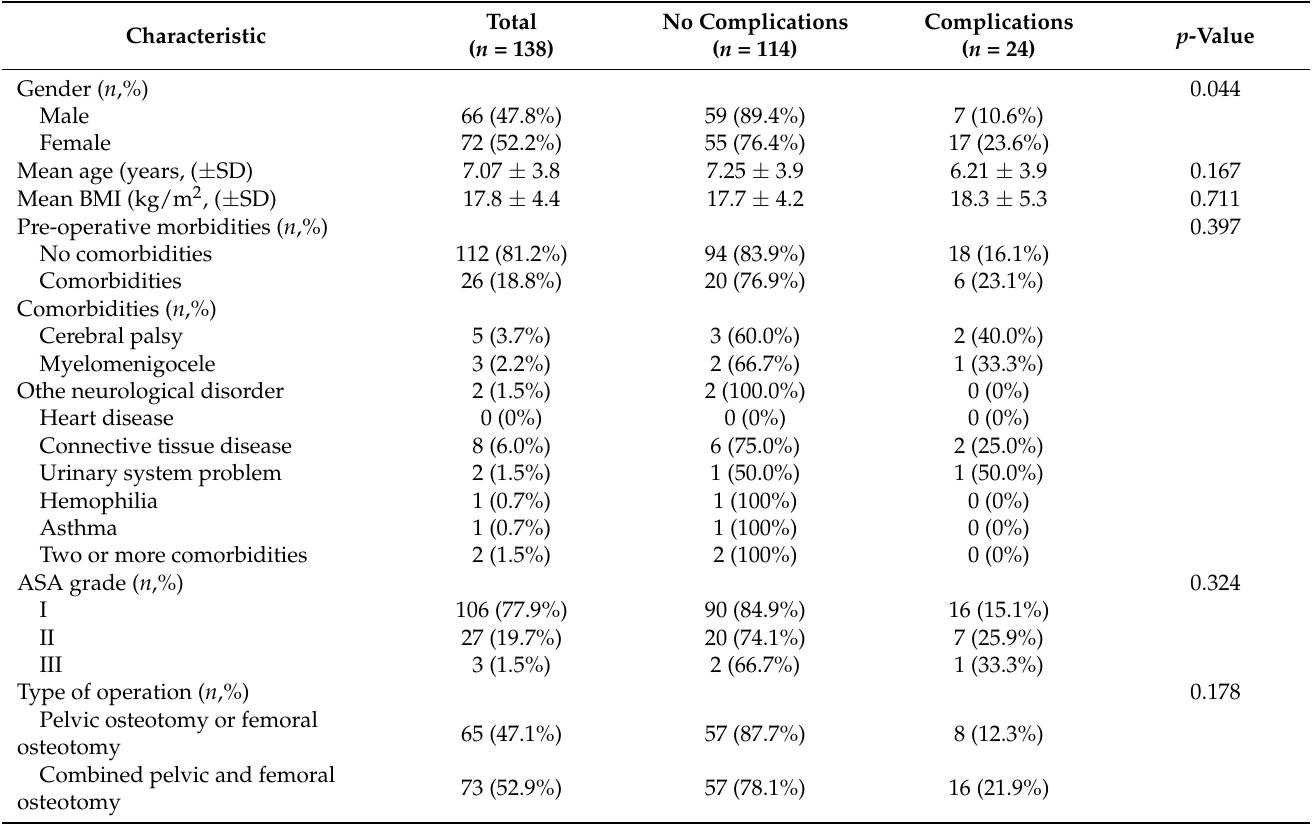
Table 1. Demographic